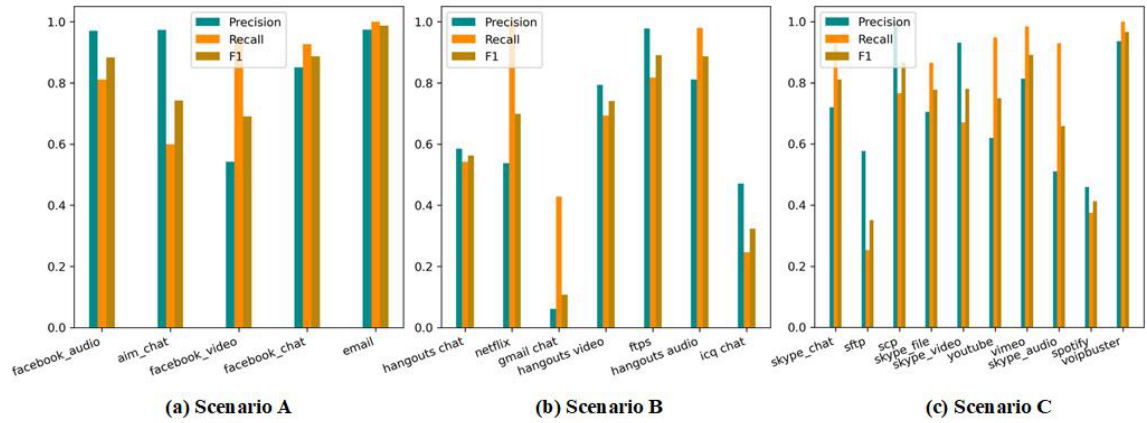
Figure 7. The identification performance of each Internet protocol in different